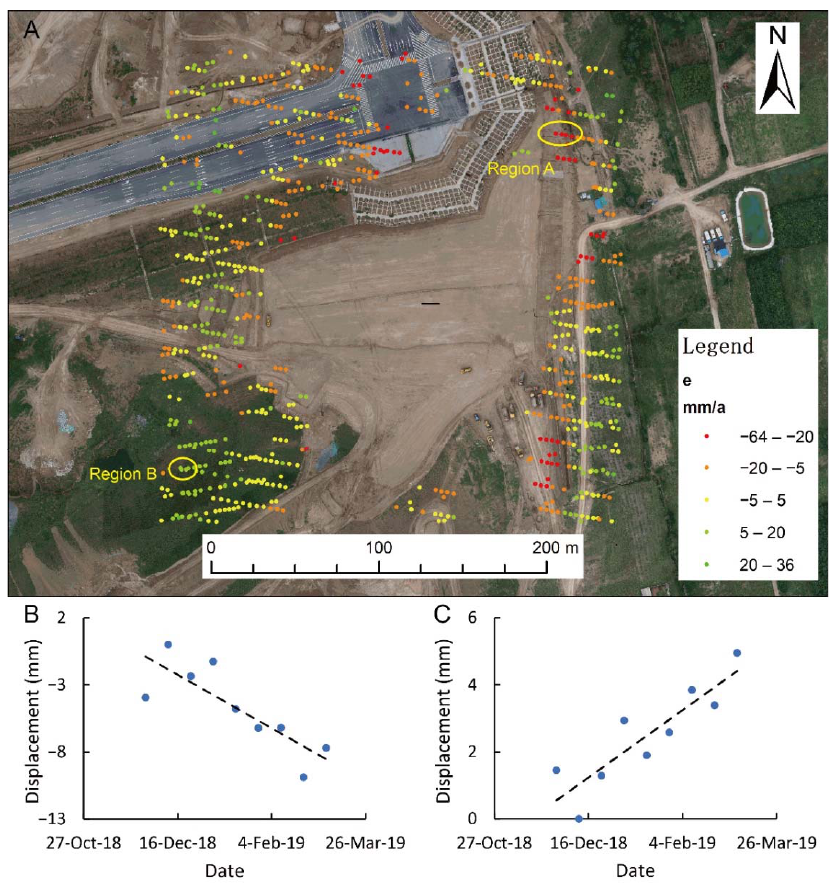
Figure 7. East–west displacement based on InSAR data (( A ) is the spatial distribution of displace ‐ ment in the east–west direction, ( B ) is the deformation in region A, and ( C ) is the deformation in region B).